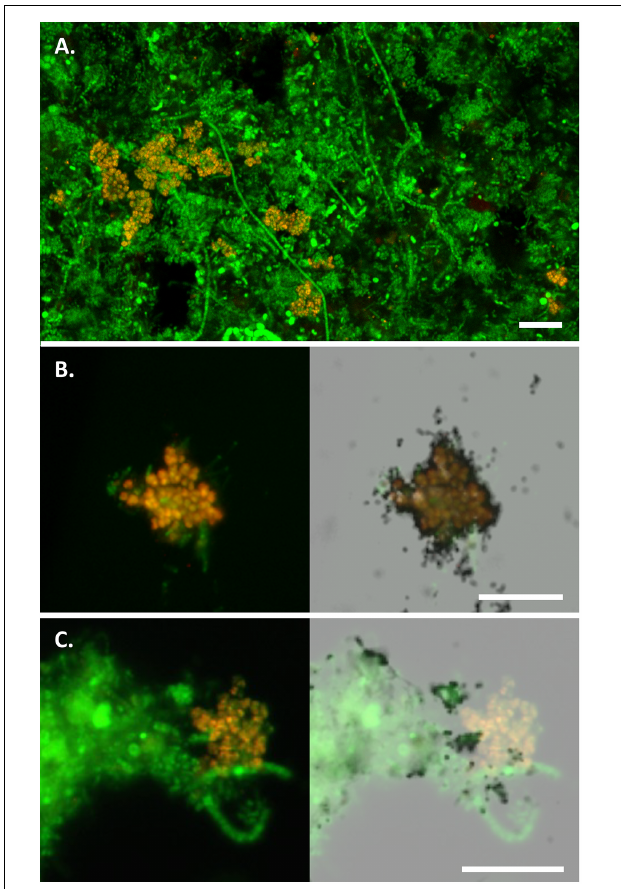
FIGURE 2 | FISH micrographs of the Micropruina spp. in full-scale activated sludge. In all images, Micropruina appear yellow [MGL-67 (red) + EUBmix (green)] and other bacteria green (EUBmix alone). (A) Composite fluorescence image of the Ejby Mølle WWTP sludge. (B,C) MAR-FISH image sets: composite fluorescence image alone (left) and with overlay of corresponding field of view with bright-field microscopy showing MAR signal (right). Cells with associated silver granules (black dots) are positive for uptake of the labeled substrate; (B) positive anaerobic uptake of 3 H-glucose; (C) negative aerobic uptake of 3 H-acetate. Scale bars indicate 10 µ